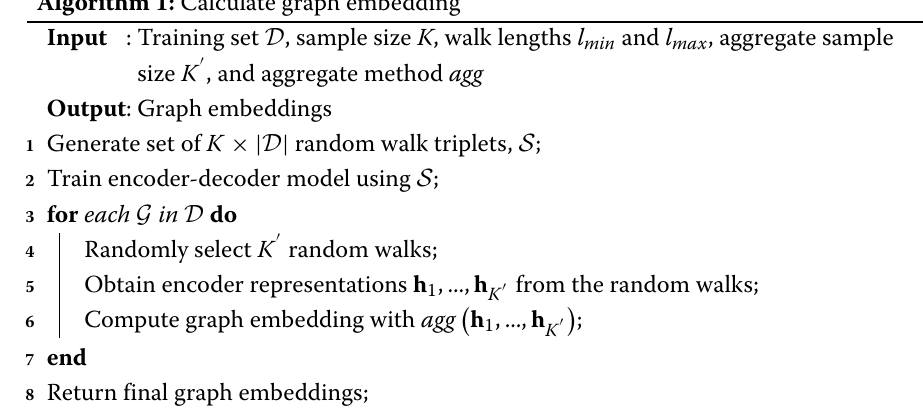
Algorithm 1: Calculate graph